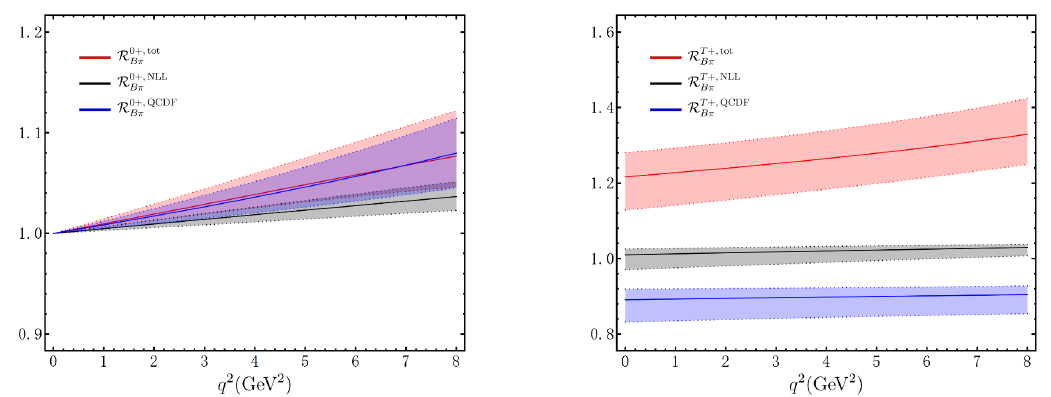
Figure 6 . Theory predictions for the large-recoil symmetry breaking corrections between the exclusive B → π form factors from the updated SCET sum rules with the bottom-meson distribution amplitudes at the twist-six accuracy. For a comparison, we further display the numerical results from the QCD factorization approach with the so-called physical form factor scheme [90] by taking the light-meson LCSR computation of the vector form factor f + theory